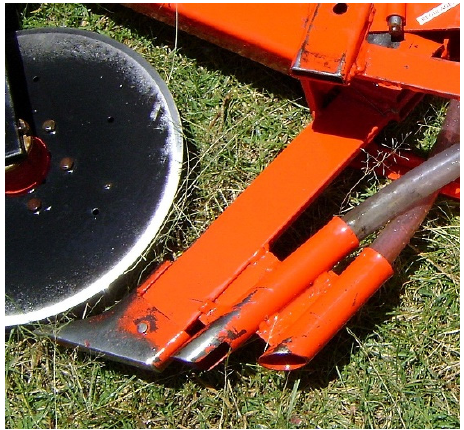
Figure 2. Narrow chisel ‐ tined slot openers for seed and fertilizer placement are suitable for low surface residue situations. A vertical disc preceding the opener will ease residue flow.